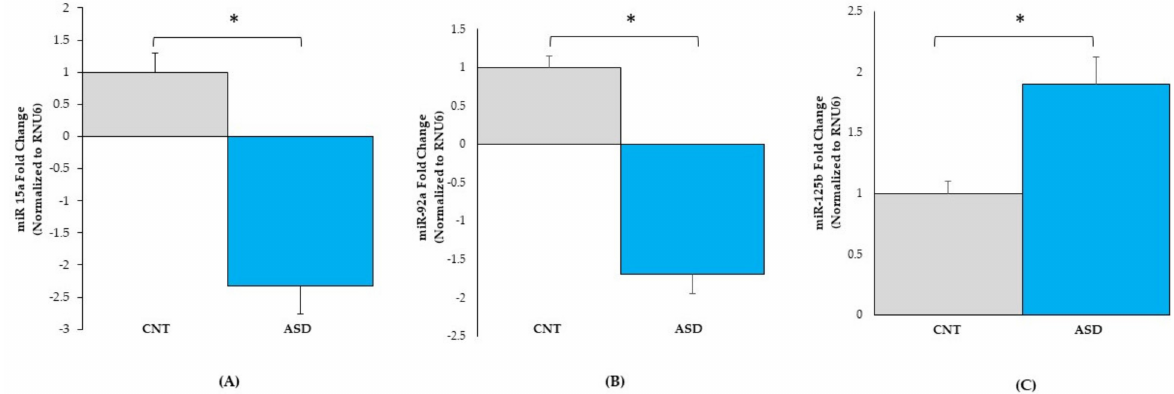
Figure 5. qRT-PCR validation of miRNA expression in control ( n = 7) and ASD ( n = 10 ) LCLs. miR- 15a-5p ( A ), miR-92a-3p ( B ), and miR-125b-5p ( C ). ASD = autism, CNT = control; * = p < 0.05 compared to controls; error bars represent standard error of the mean.